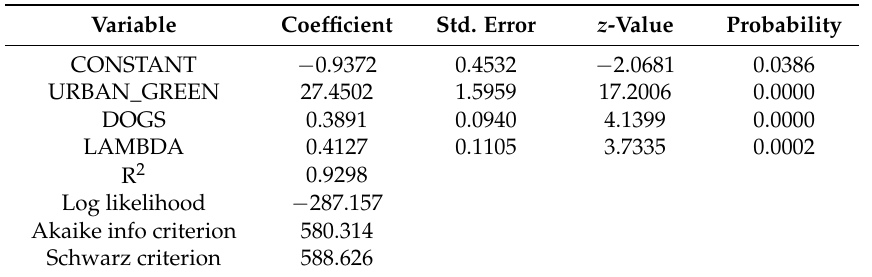
Table 6. Spatial Error